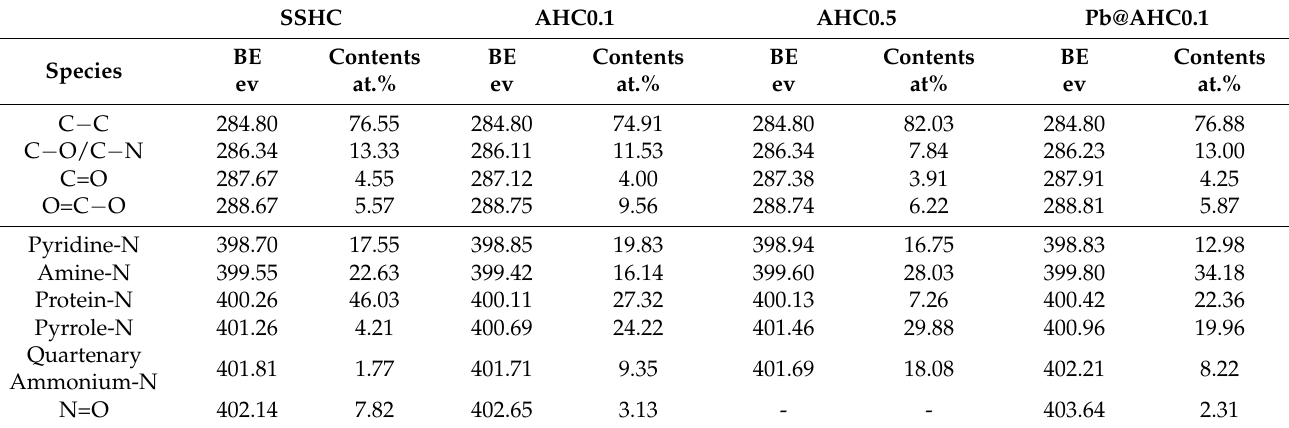
Table 3. Deconvolution results of C1s and N1s spectra.